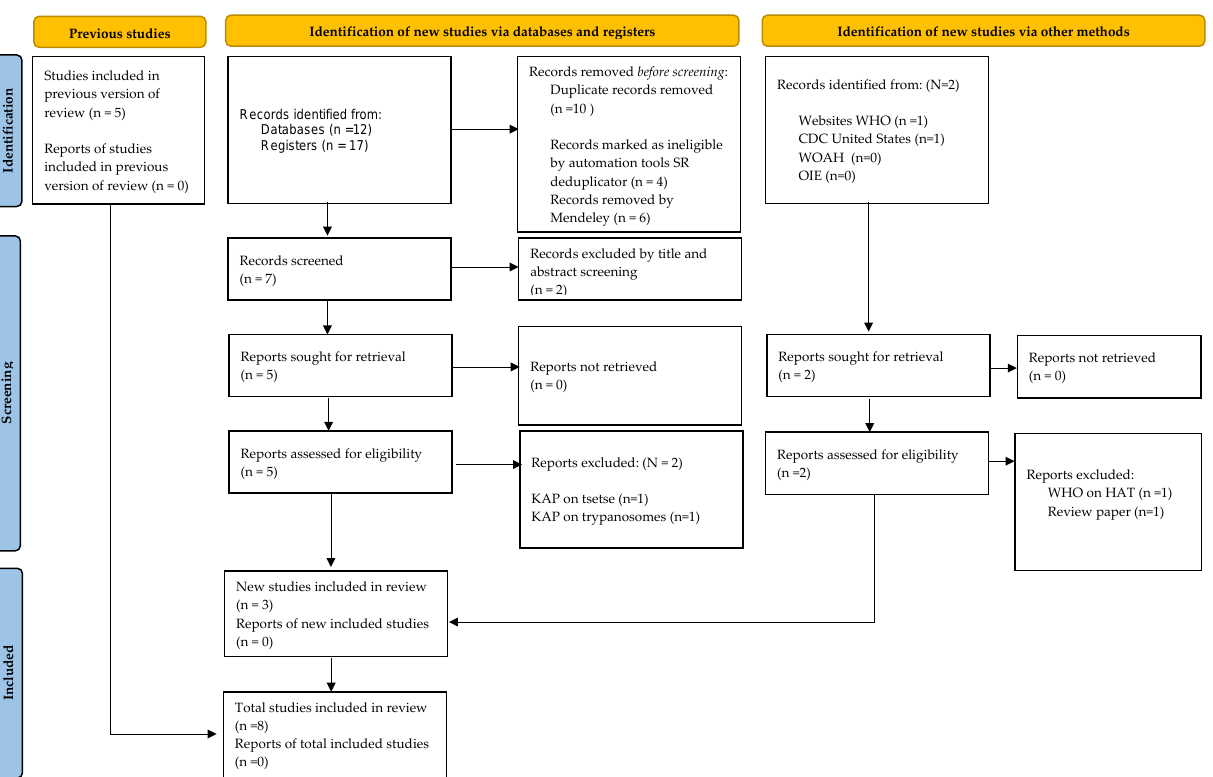
Figure 1. PRISMA checklist showing articles identified from the databases, Google, and in-citation search on knowledge, attitude, and practices on African animal trypanocide